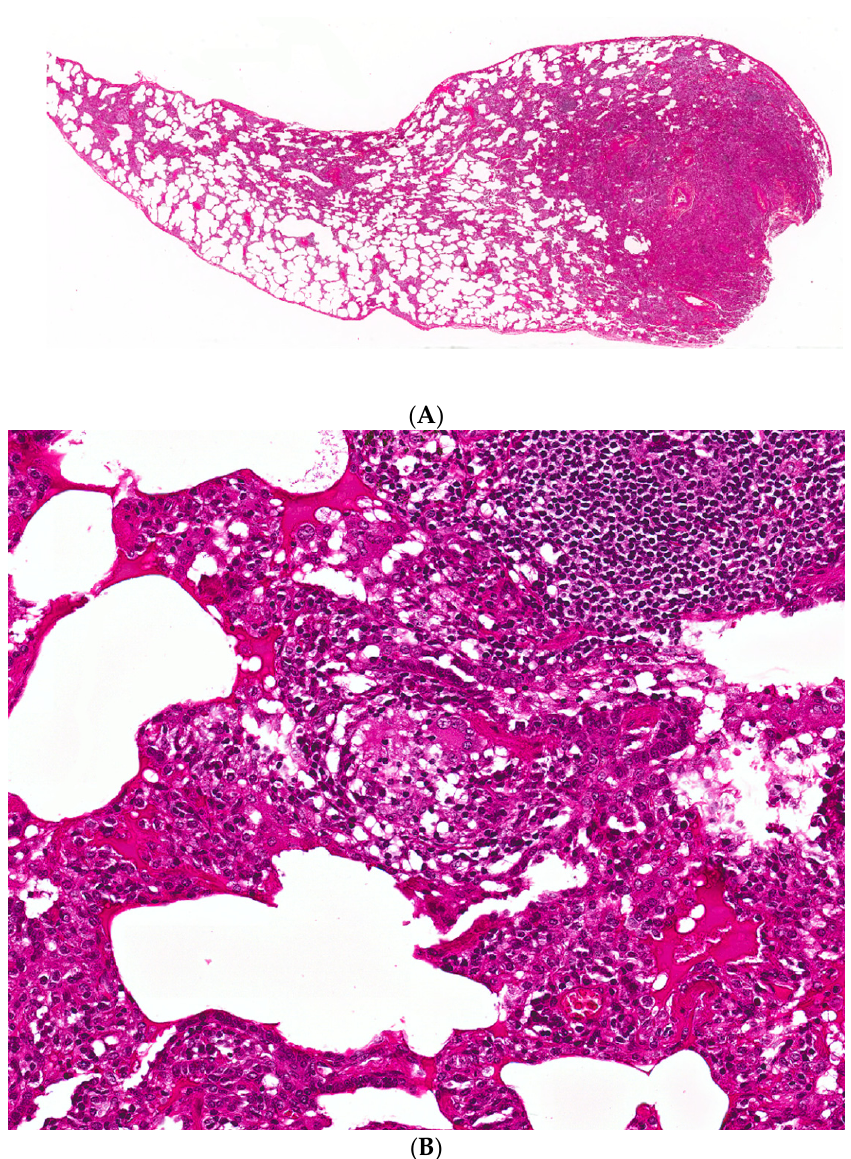
Figure 2. ( A ) A case of hypersensitivity pneumonitis shows peribronchiolar chronic inflammation of varying intensity around bronchovascular bundles. ( B ) A single, small, poorly-formed granuloma is found within the interstitium